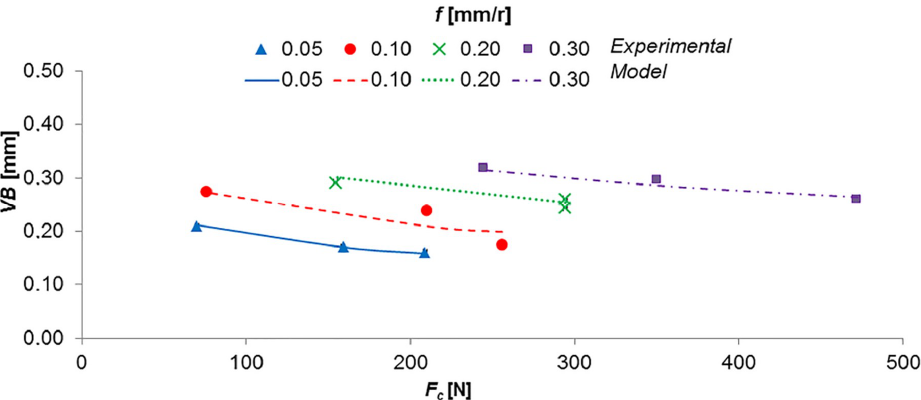
Figure 10. Experimental data vs. parametric model for VB = f ( f, F c ).